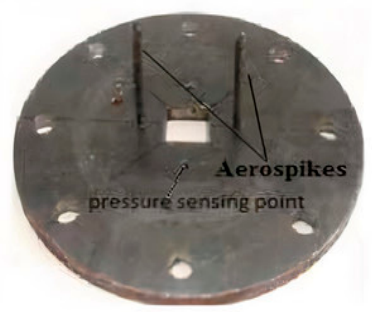
Figure 12. Control plates with aerospike [21].